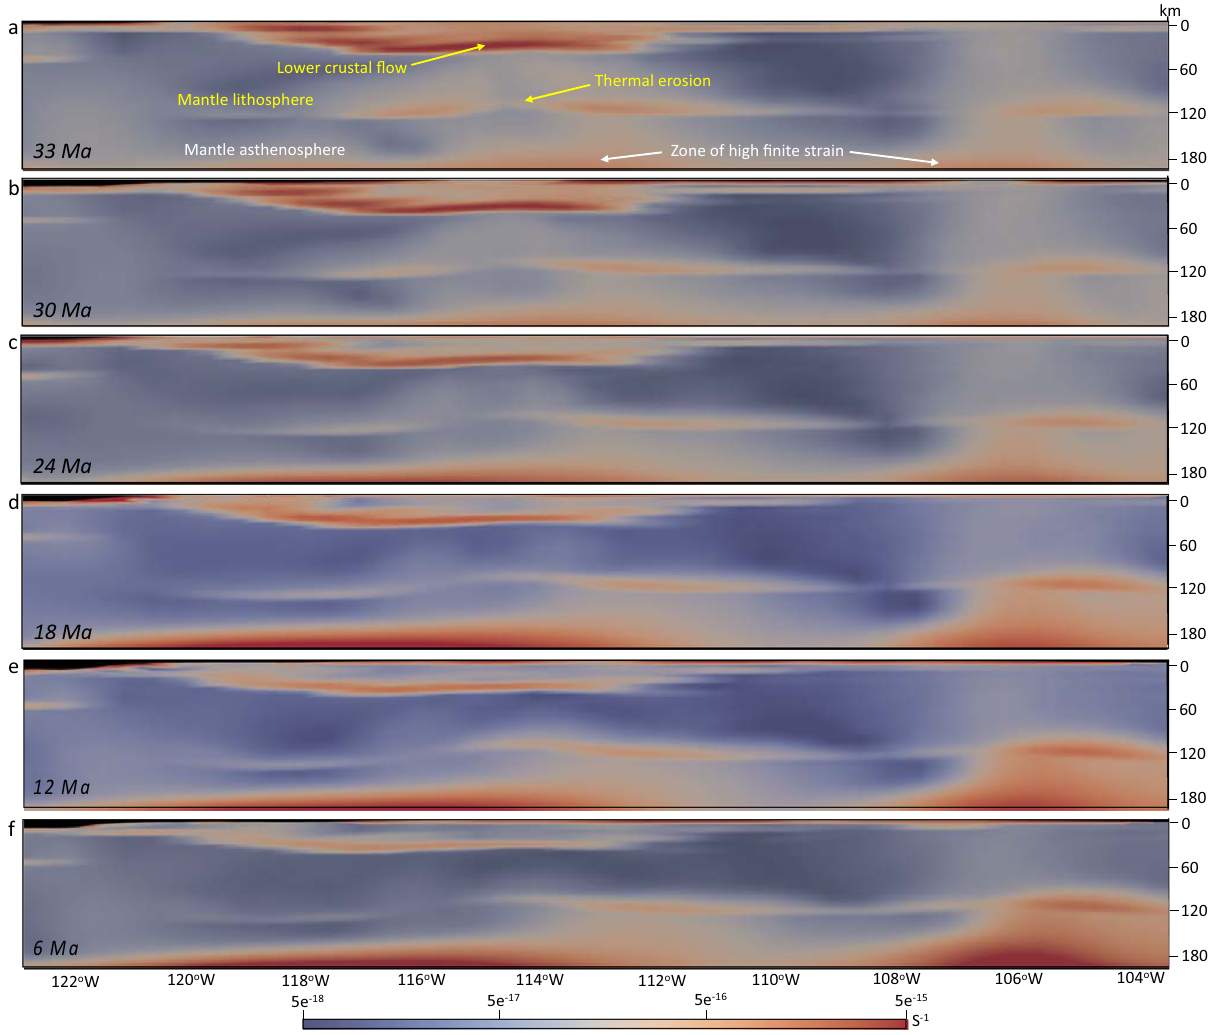
Fig. 7 Lithosphere dynamics and tectonic model achieved from 4-D thermo-mechanical model of the North American lithosphere. a – f Vertical cross- sections of the 3-D lithosphere and mantle asthenosphere at 37°N showing the evolution of fi nite strain rate within the Basin and Range Province, Colorado Plateau, and Great Plains in southwestern North America at 33, 30, 24, 18, 12, and 6 Ma,